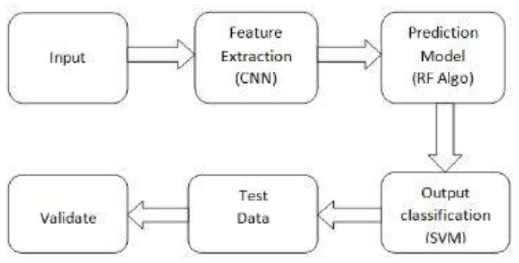
Figure 1. System flow diagram for the Deep Learning